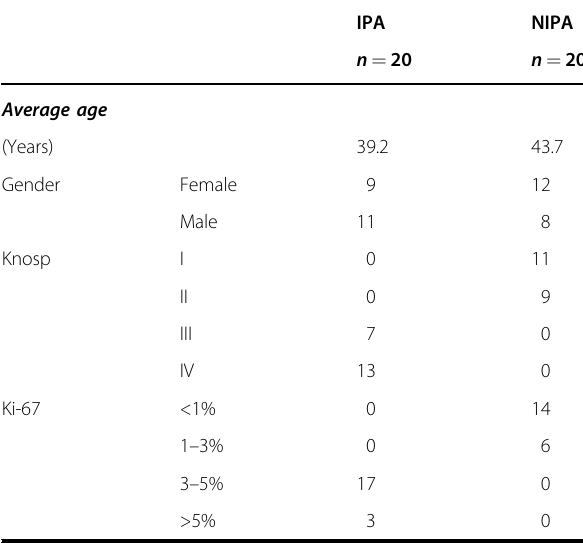
Table 1 The clinical characteristics of the